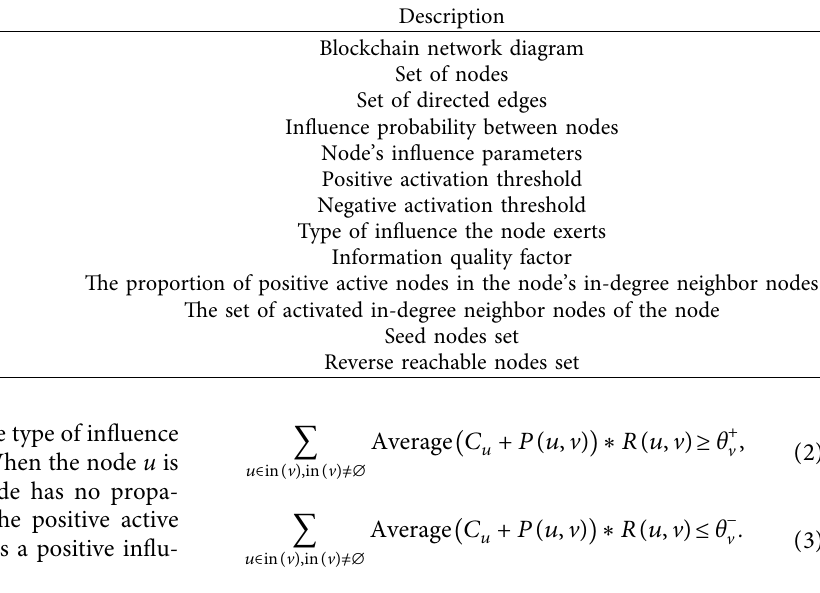
Table 1: Frequently used